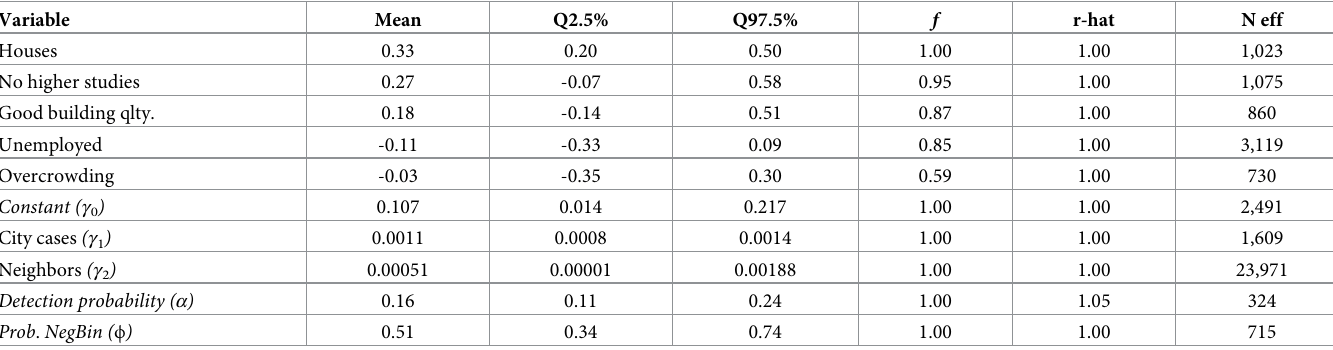
The effects of the demographic covariates and of neighboring and citywide cases are displayed. The mean and 95% interquantile range of the posterior distribution of the corresponding model parameters are shown, together with the fraction f of the posterior with the same sign as the mean, r-hat as indicative of convergence and ‘N eff’, the effective sample